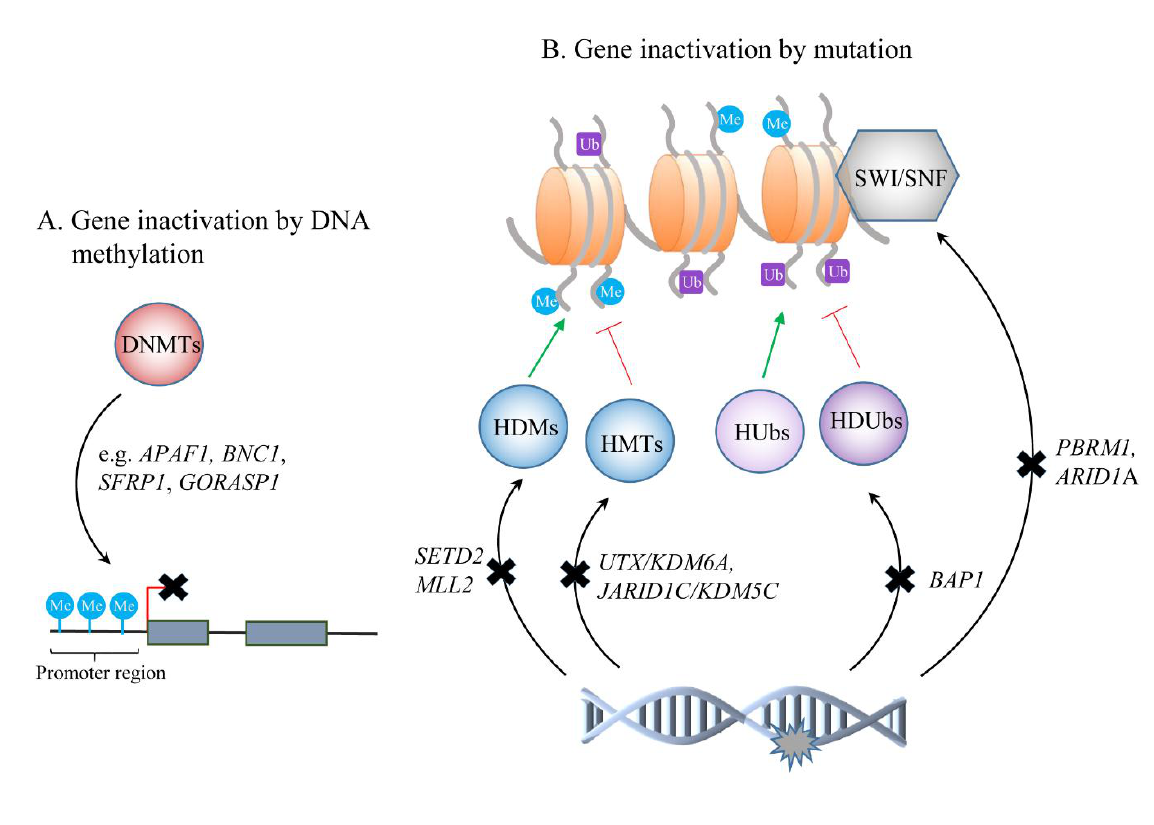
Figure 1. Schematic representation of epigenetic changes identified in ccRCC tumors. DNMTs - DNA methyltransferases; HDMs - histone demethylases; HMTs - histone methyltransferases; Hubs - histone ubiquitinases; HDUbs - histone deubiquitinases; SWI/SNF - chromatin remodeling